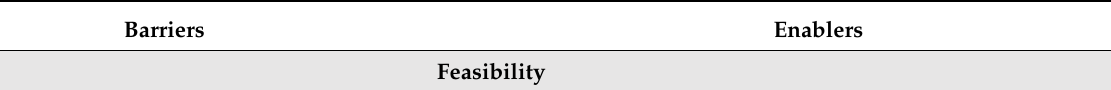
Table 5. Barriers and enablers for robot-mediated